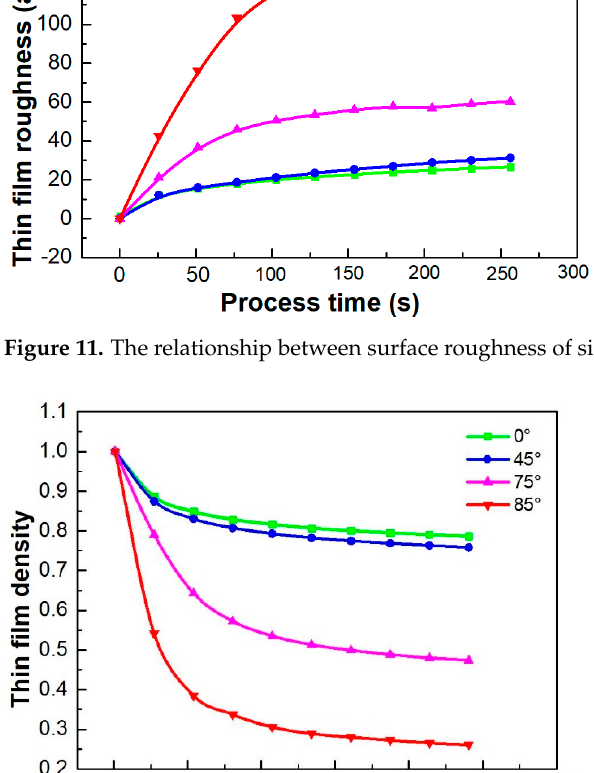
Figure 12. The relationship between thin-film density and process time.